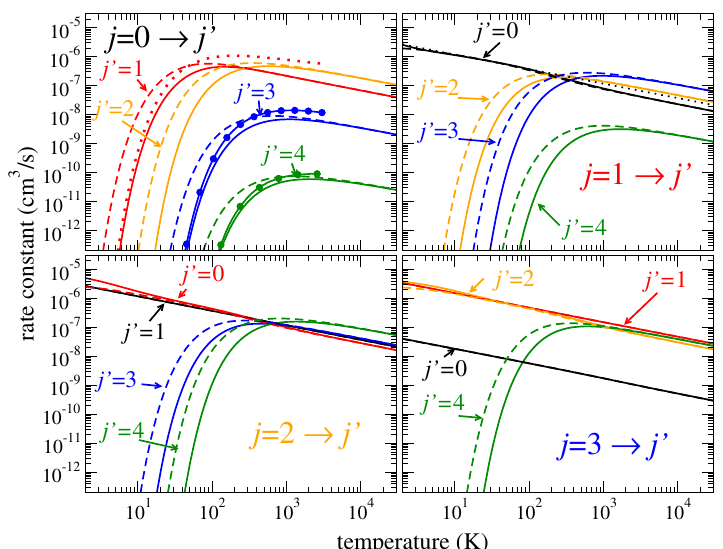
Figure 5. Thermally averaged rate coefficients for several rotational (de-)excitation transitions of 4 HeH + (solid lines) and 4 HeD + (dashed lines). Dotted lines in the upper-left panel are the calculations by Hamilton et al. [32], and lines with circles are those by ˇCurík and Greene [18] for 4 HeH + .